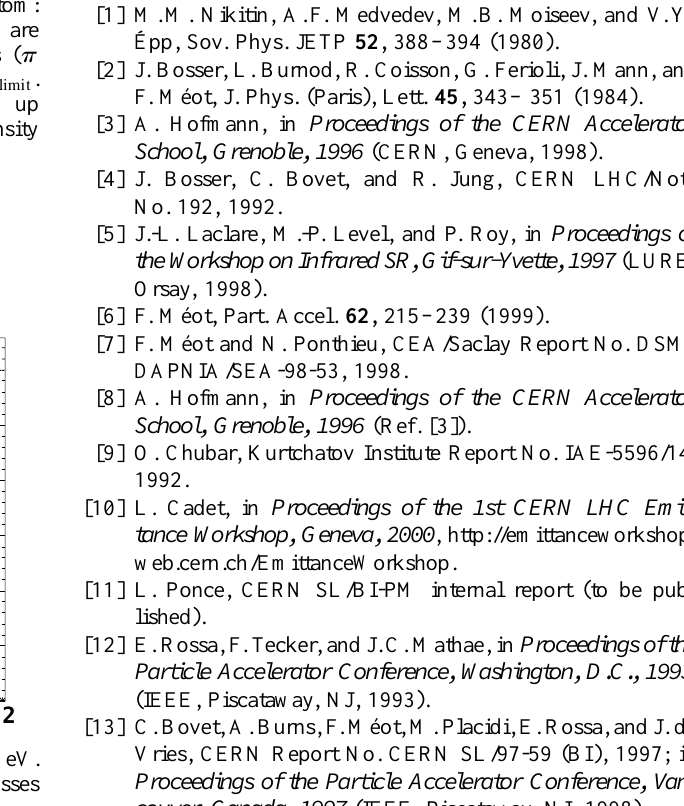
lead to single signal duration of the same order of magni- tude as the time interval between two dipoles, which re- quires higher order expansion of Eq. (2), basically up to second order in v to get precise enough f , c angular dis- tributions over an aperture of a few times 1 (cid:4) g , as shown in Fig. 14 in the case of an interfering dipole pair